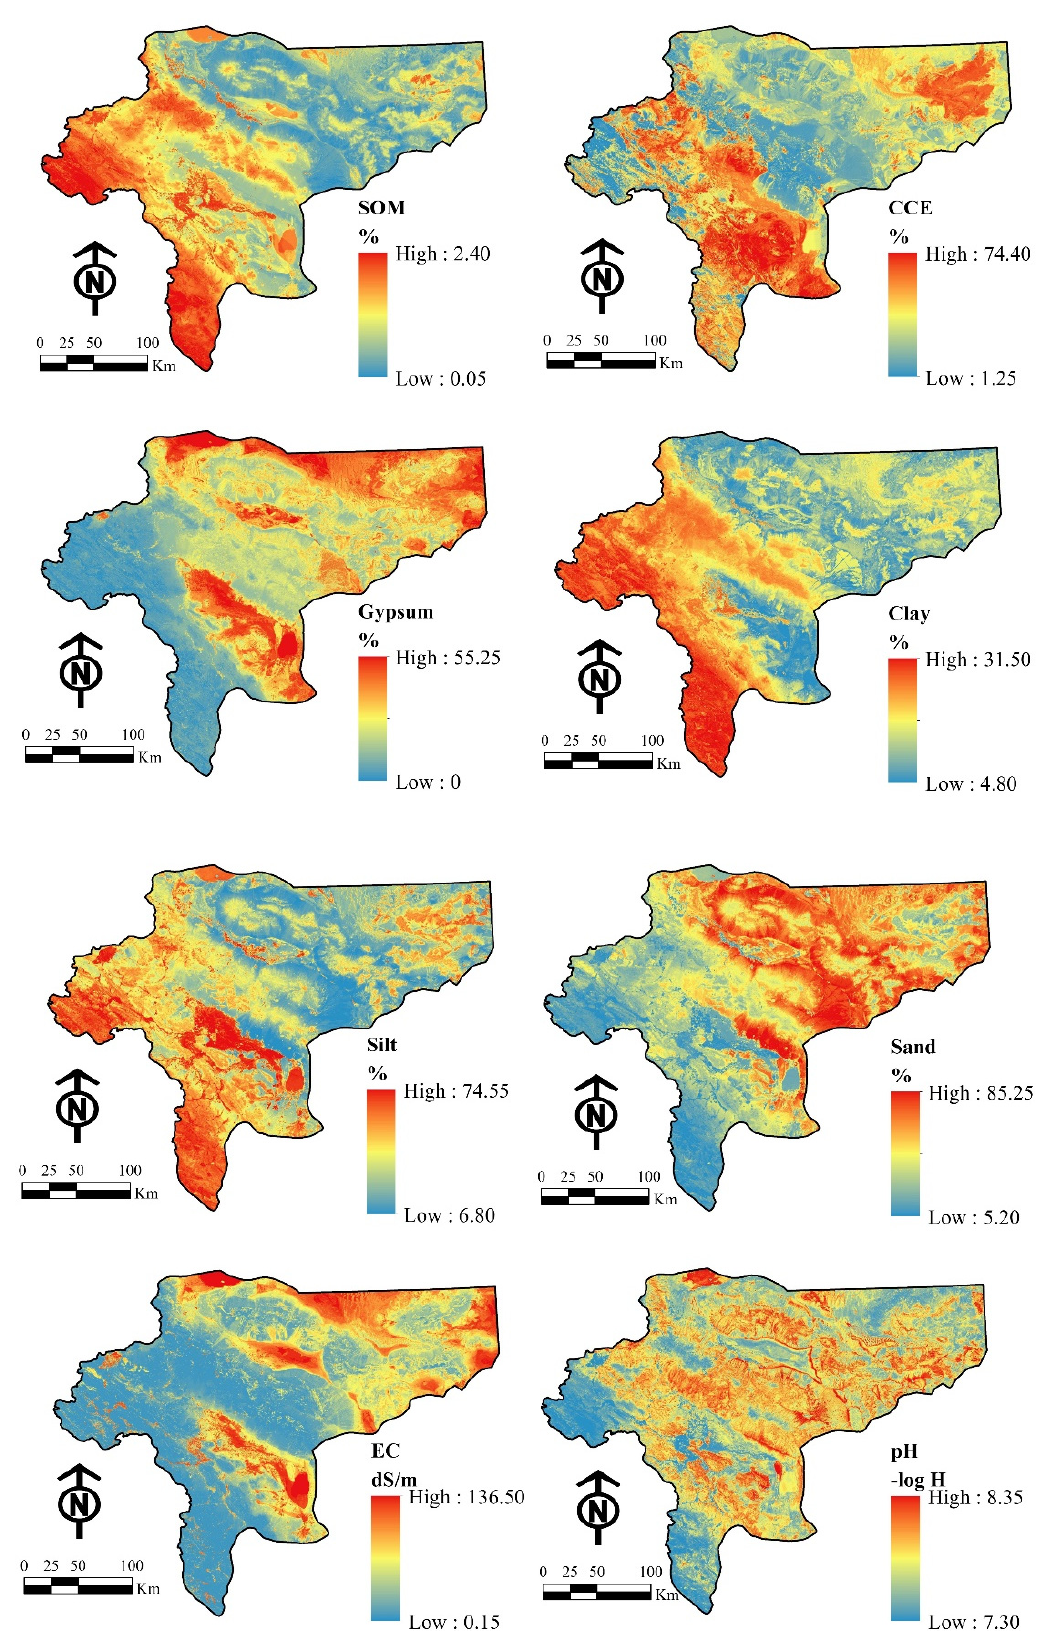
Figure 4. Spatial distribution soil properties for the Isfahan province at a 30 m spatial resolution. The maps shown are produced using the best-performing model averaging technique.